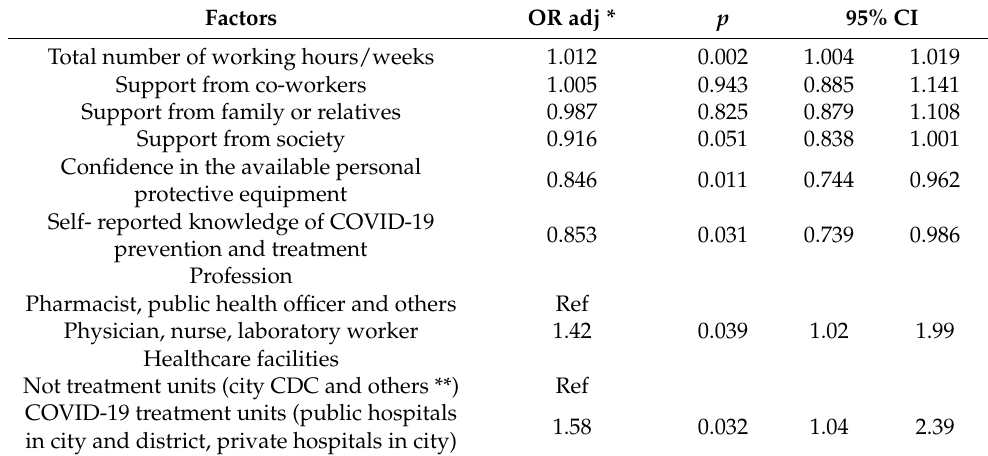
Table 3. Predictors of stress among healthcare workers by multiple logistic regression ( n =